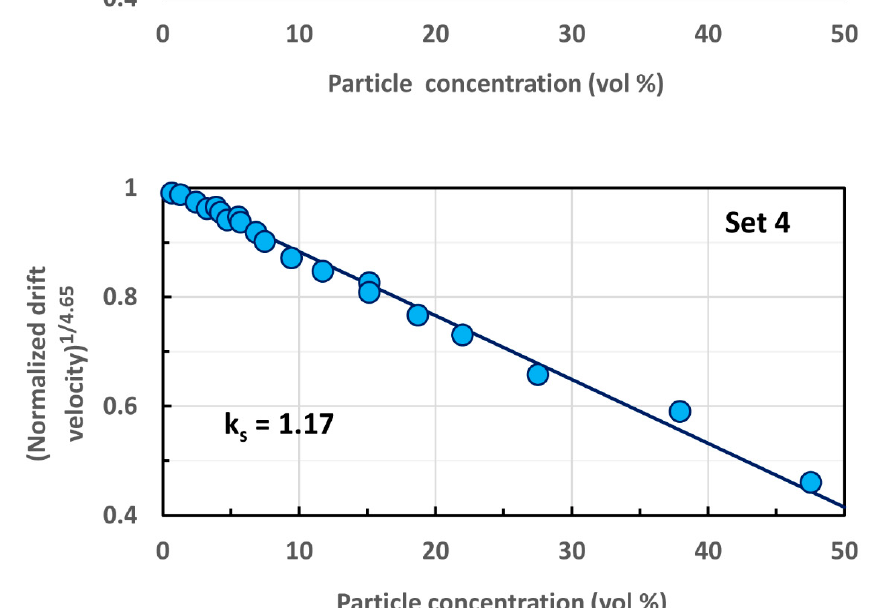
Figure 6. Typical plots of (cid:3427)𝑈 (cid:3005)(cid:3045)(cid:3036)(cid:3033)(cid:3047),(cid:3015) (cid:3431)